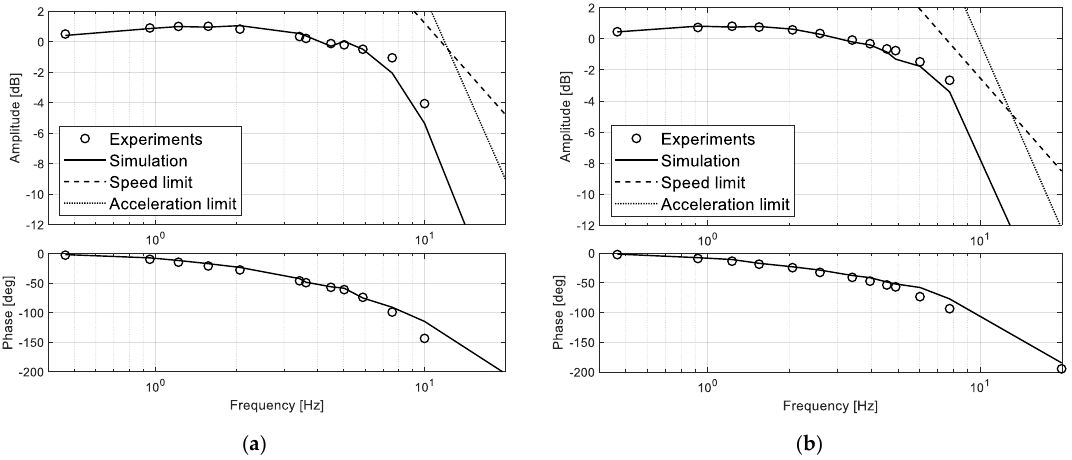
Figure 8. Time-domain model validation: position tracking in AAEP mode with 100 kN/m spring-type loading (in Equation (24), k e = 10 5 N/m); ( a ) output position; ( b ) motors quadrature currents ( x o max = 25 × 10 − 3 m; I q max = 25 A).